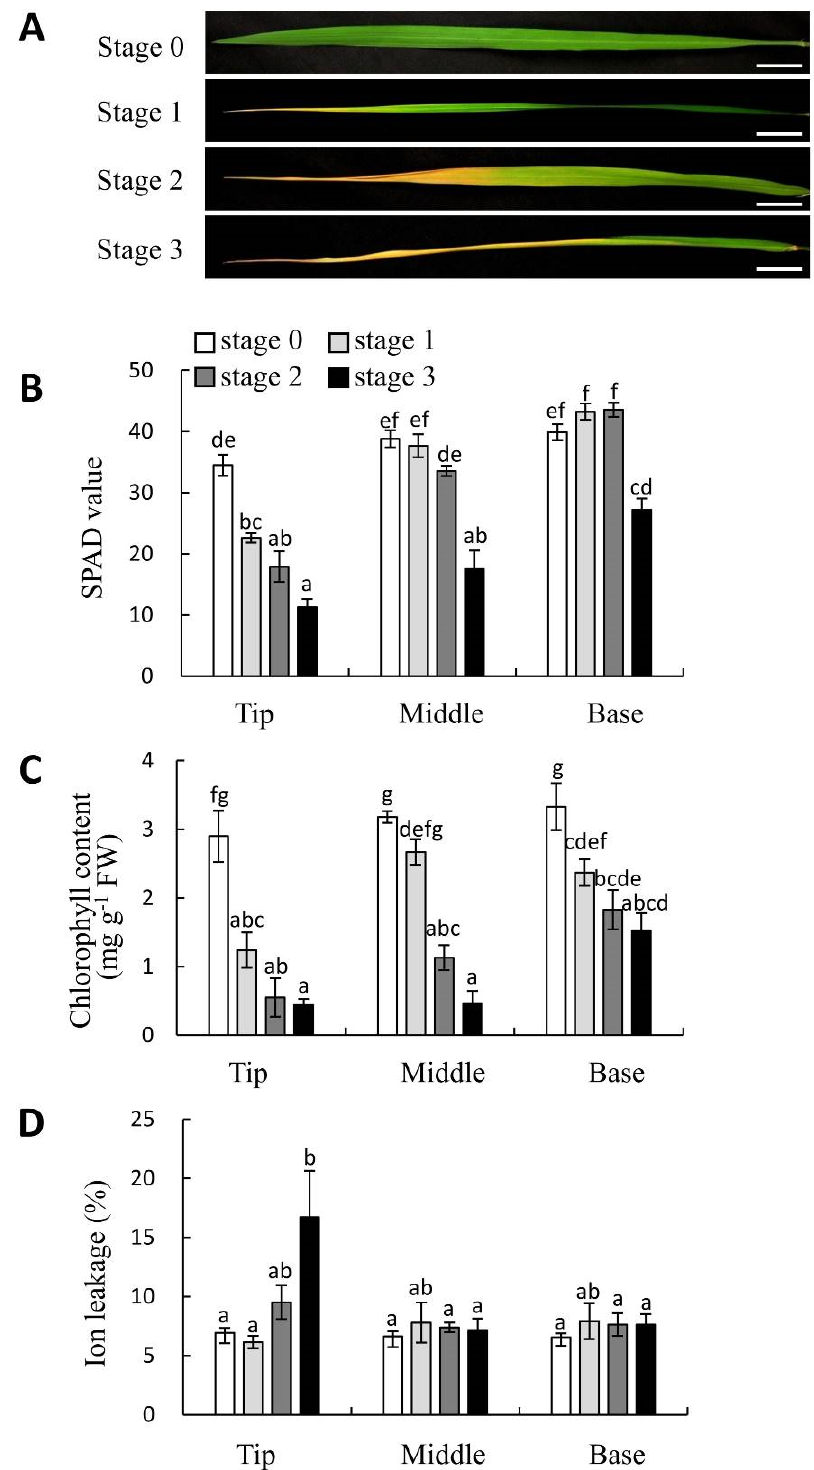
Figure 4. Physiological changes of yellowing hybrid leaves. ( A ) Stages of yellowing: Stage 0, no yellowing; Stage 1, 1/4 of leaf yellow; Stage 2, 1/2 of leaf yellow; Stage 3, 3/4 of leaf yellow. Scale bars indicate 2 cm. ( B ) Changes in the SPAD values at the tip, middle, and base of leaves during the progression of yellowing. ( C ) Changes in chlorophyll content during the progression of yellowing. ( D ) Changes in ion leakage during the progression of yellowing. Values and error bars ( B – D ) indicate mean ± SE values ( n = 3), and different lowercase letters in each plot ( B – D ) indicate significant differences (Tukey HSD test, P < 0.05).